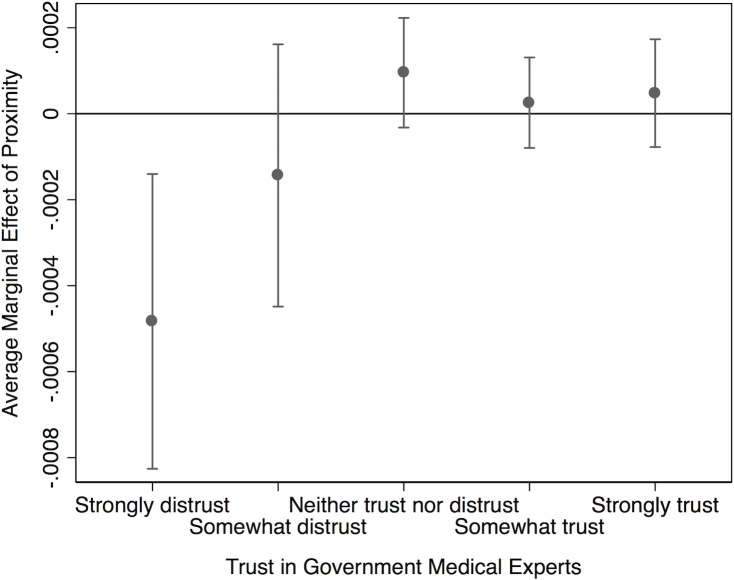
Effect of proximity by trust in GMEs.